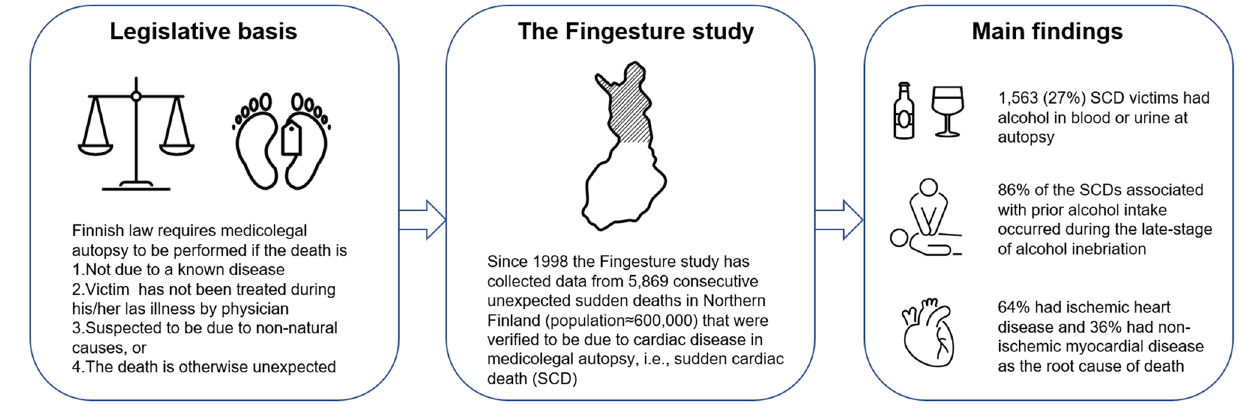
Figure 1. Schematic illustration of the study protocol and